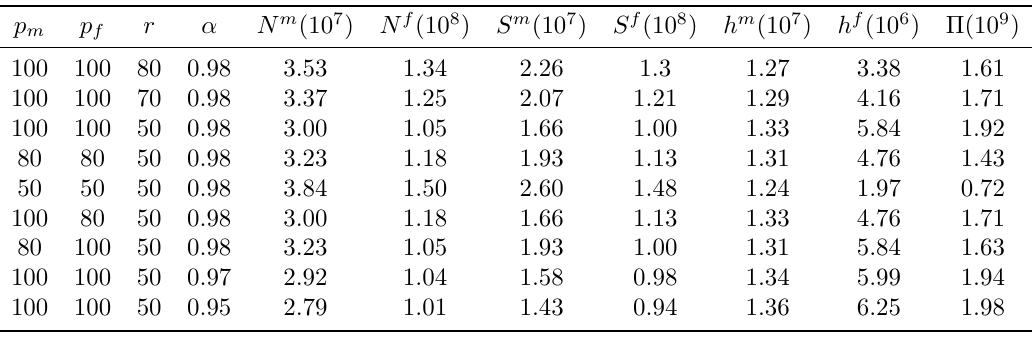
Table 3: The bio-economic equilibrium results for different economic values when using the biological values given in Table 2 (last row). N m is the male pre-harvest stock size in numbers, N f is the female pre-harvest stock size in numbers, S m is the male post-harvest stock size in numbers, S f is the female post-harvest stock size in numbers, h m is the annual male harvest, h f is the annual female harvest and Π is the annual net revenue from such a